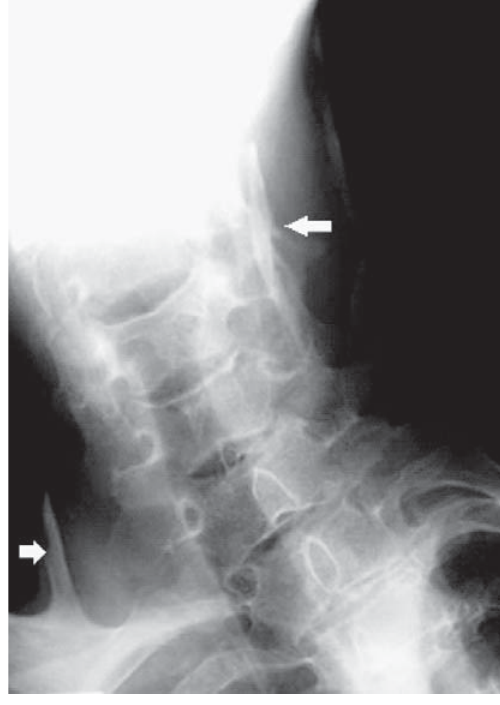
Fig 3. X-ray cervical spine AP view showing heterotropic bone formation in paravertebral and subcutaneous structures (white arrow). Degenerative changes of cervical spine is also evident.